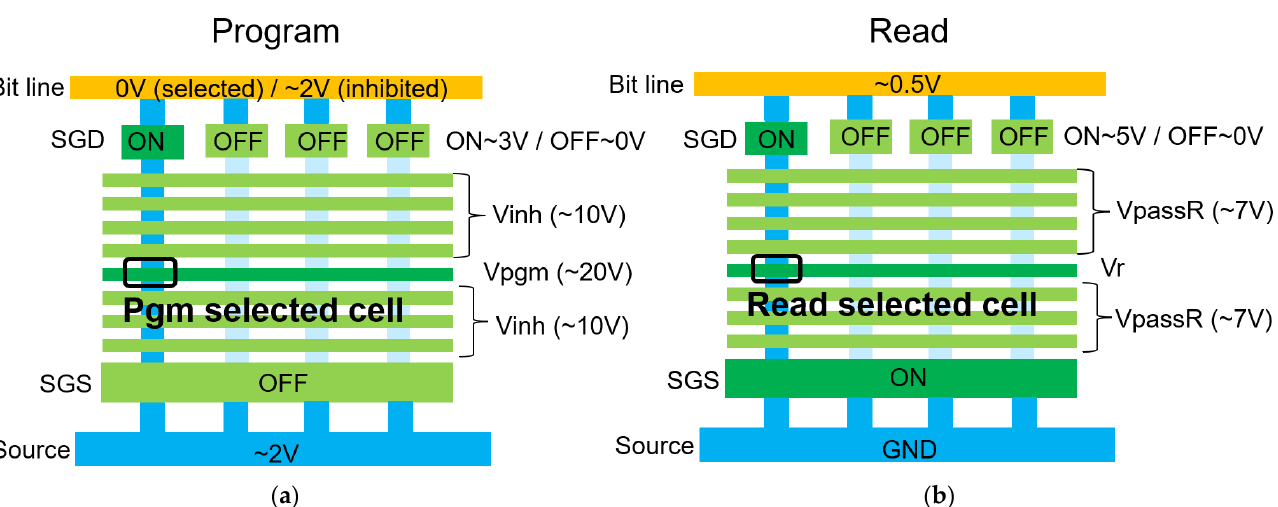
Figure 3. Erase schemes of 3D NAND. ( a ) Body erase scheme directly biases the channels at erase voltage. Holes are supplied from the Si-substrate. ( b ) GIDL erase scheme generates electron-hole pairs at the source and drain junctions. The generated holes are supplied to the channels to boost the potential to around the erase voltage.